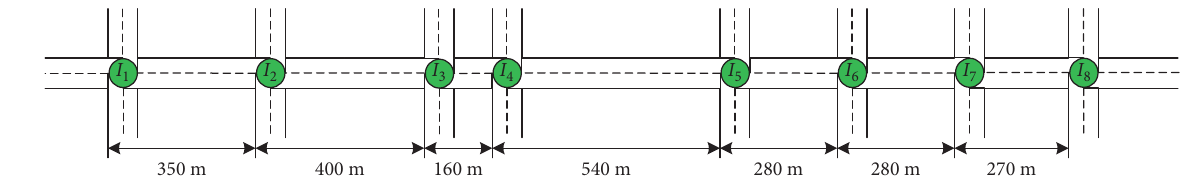
Figure 10: Structure diagram of the selected